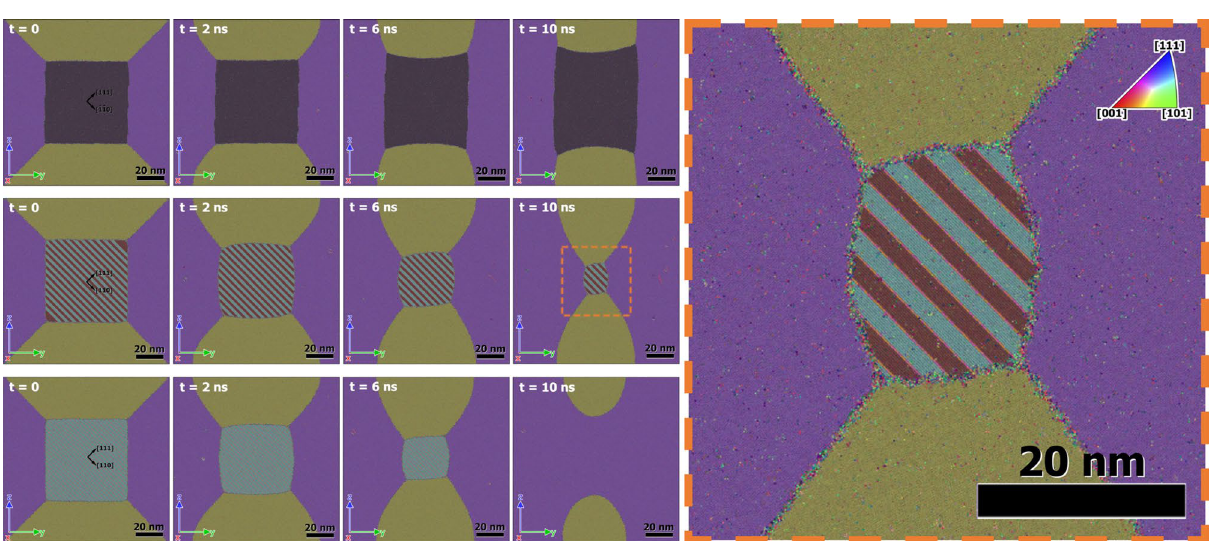
6 Figure 6. Recrystallization in artificially constructed systems of ∼ 17 × 10 atoms in quasi-2D geometry ( ∼ 14.4 nm × ∼ 121 nm × ∼ 121 nm ) in periodic boundary conditions in all directions. On the left: snapshots of the system structures at t = 0 , 2, 6, and 10 ns . The first row is for the system free of ingrain defects. The second row is for the system with 38 twin boundaries (at t = 0 ) in the central rectangular grain. The third row is for the system with 36 stacking fault planes (at t = 0 ) in the central grain. Grain orientation colouring was done using PTM analysis. On the right, the enlarged central grain structure with nanotwins in the box designated by the dashed rectangle for t = 10 ns is